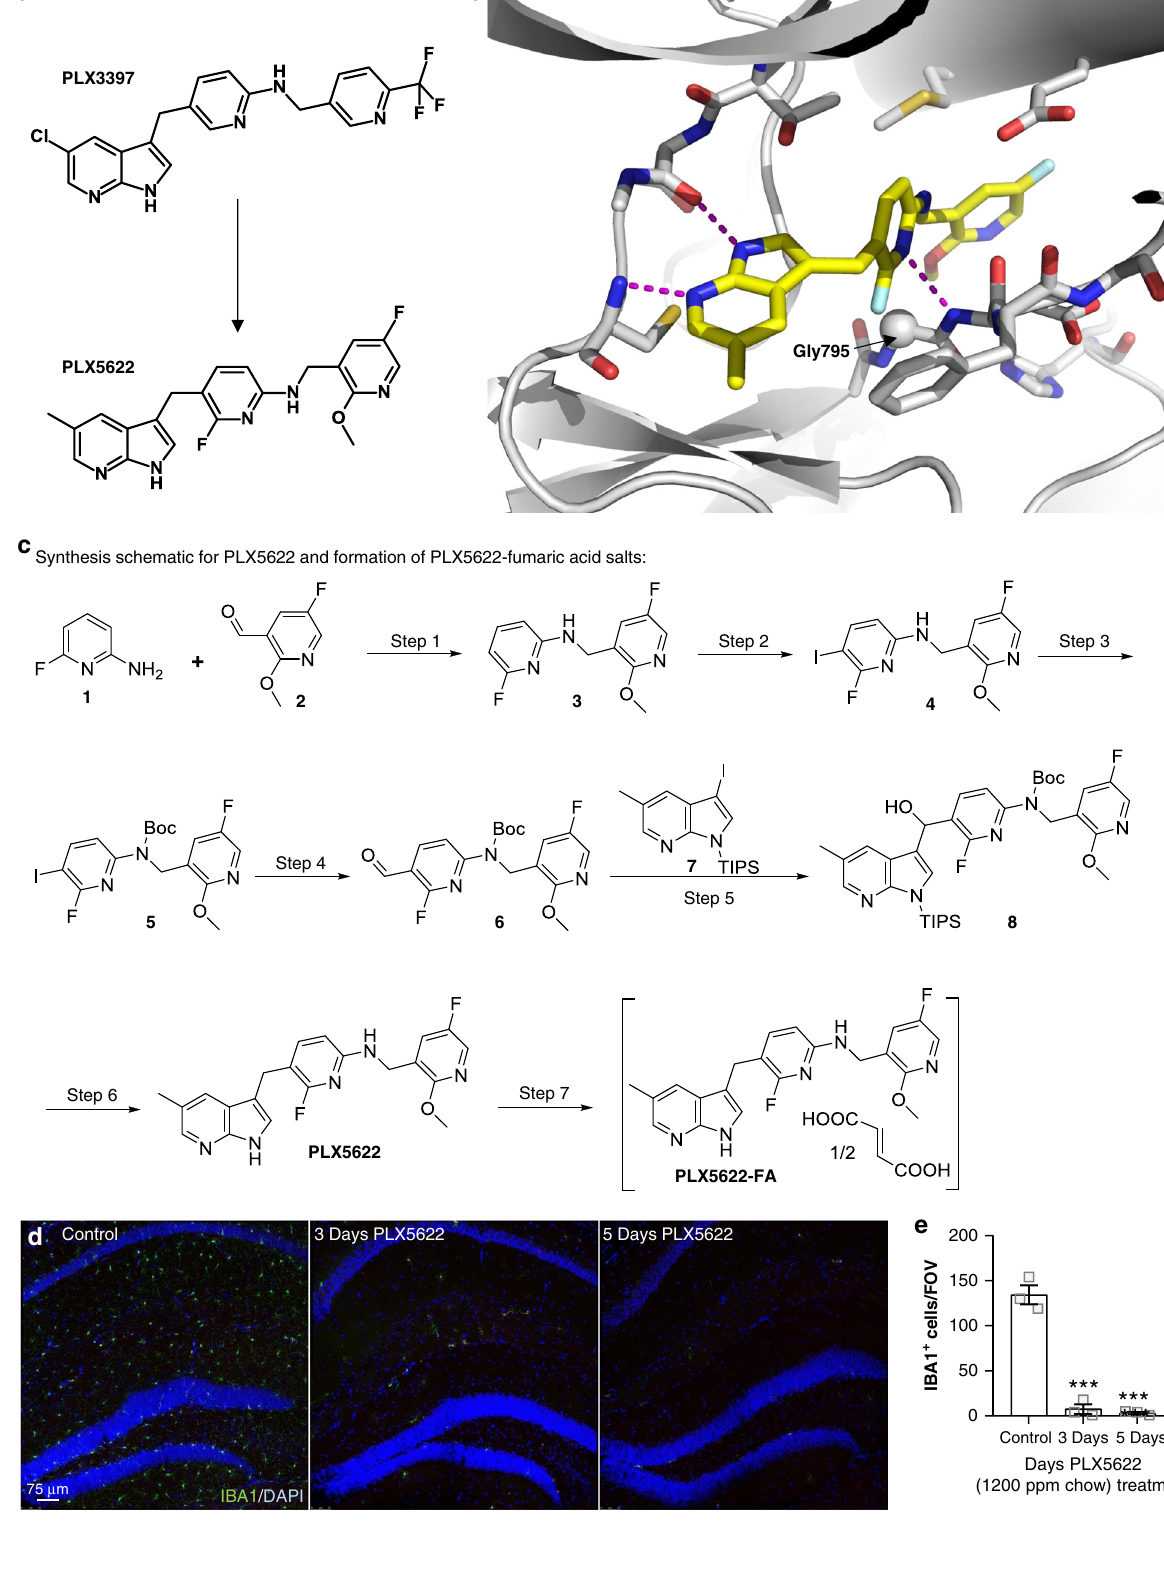
Fig. 3g, h) and motor-function (open fi eld; Supplementary Figure 3A – D). Compared to wild-type animals, 5xFAD